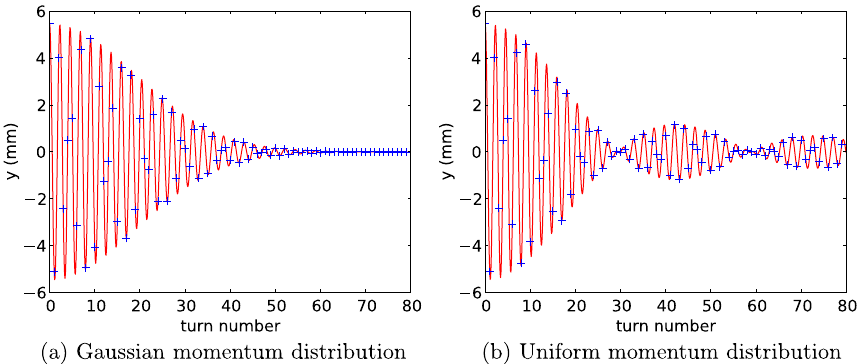
FIG. 3. Plots of bunch centroid vs turn number. The way in which the particle beam decoheres is dependent not only upon the spread of momentum, but also the form of the momentum